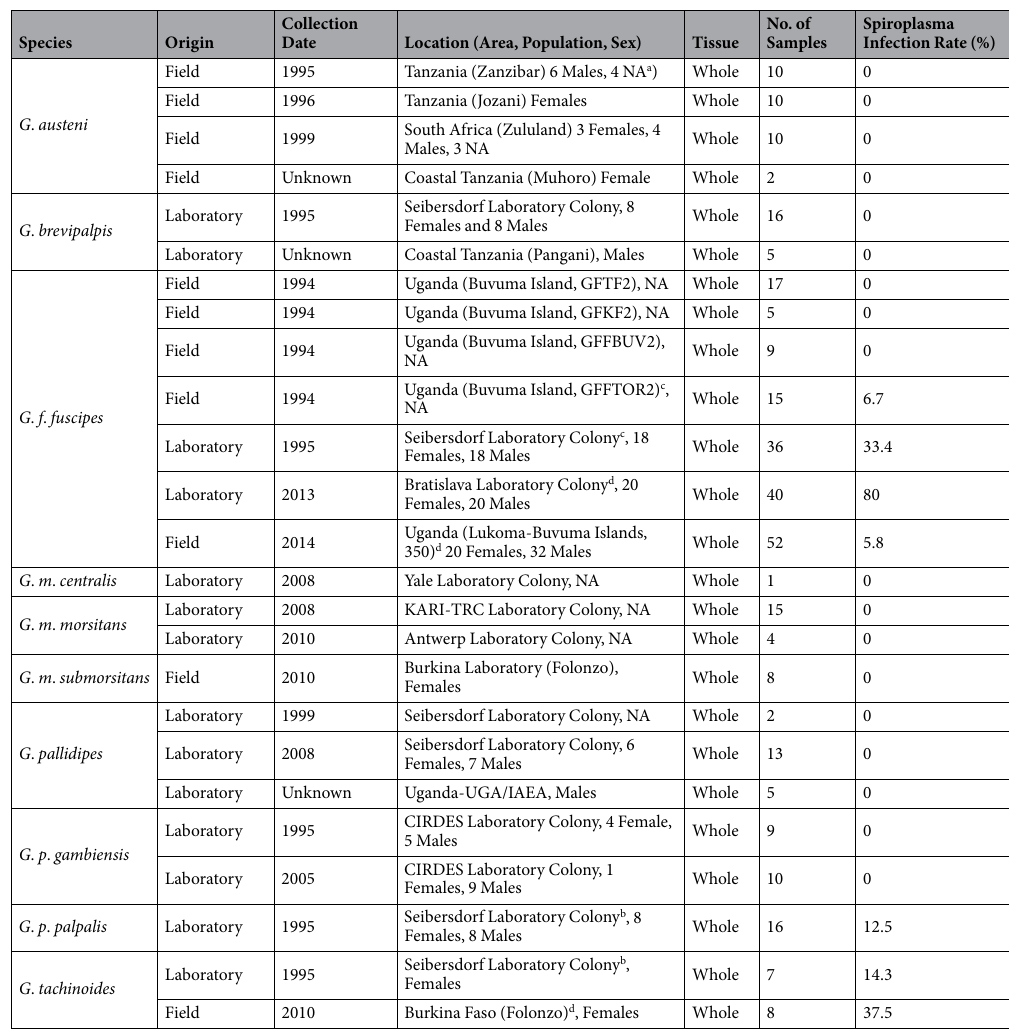
Table 1. Spiroplasma prevalence in ten Glossina species. a Sex of individuals is not known. b Characterization of Spiroplasma infection was based only on 16S rRNA gene sequencing. c The Seibersdorf laboratory-colony was established from the Central African Republic in 1986. This colony was transferred to Bratislava, Slovakia in 2009. d Full MLST